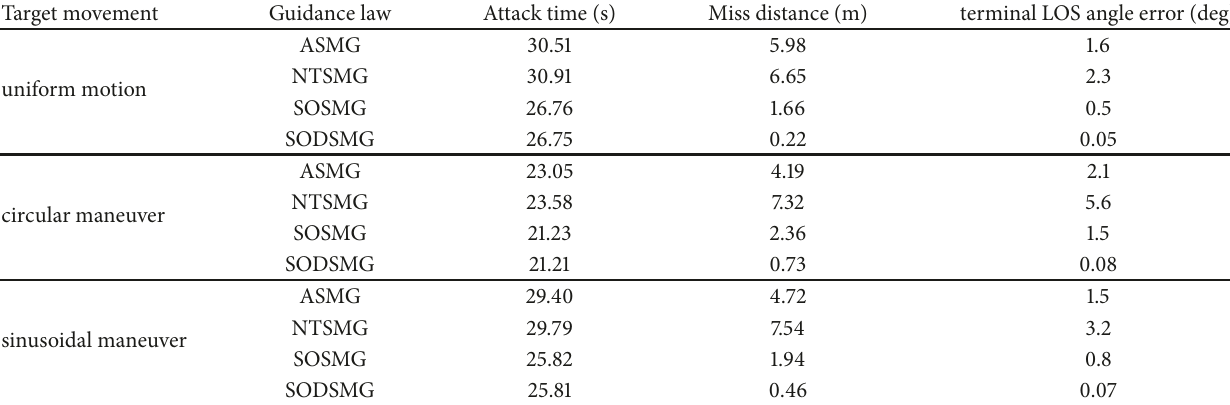
Table 1: Simulation results of attack time, miss distance, and terminal LOS angle